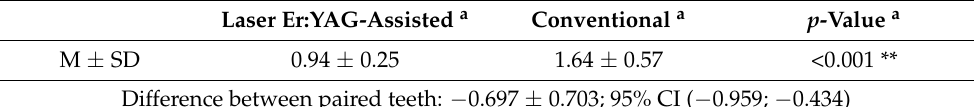
Table 2. The results of the statistical analysis of the working time. Laser Er:YAG-Assisted a Conventional a p -Value a 0.94 ±